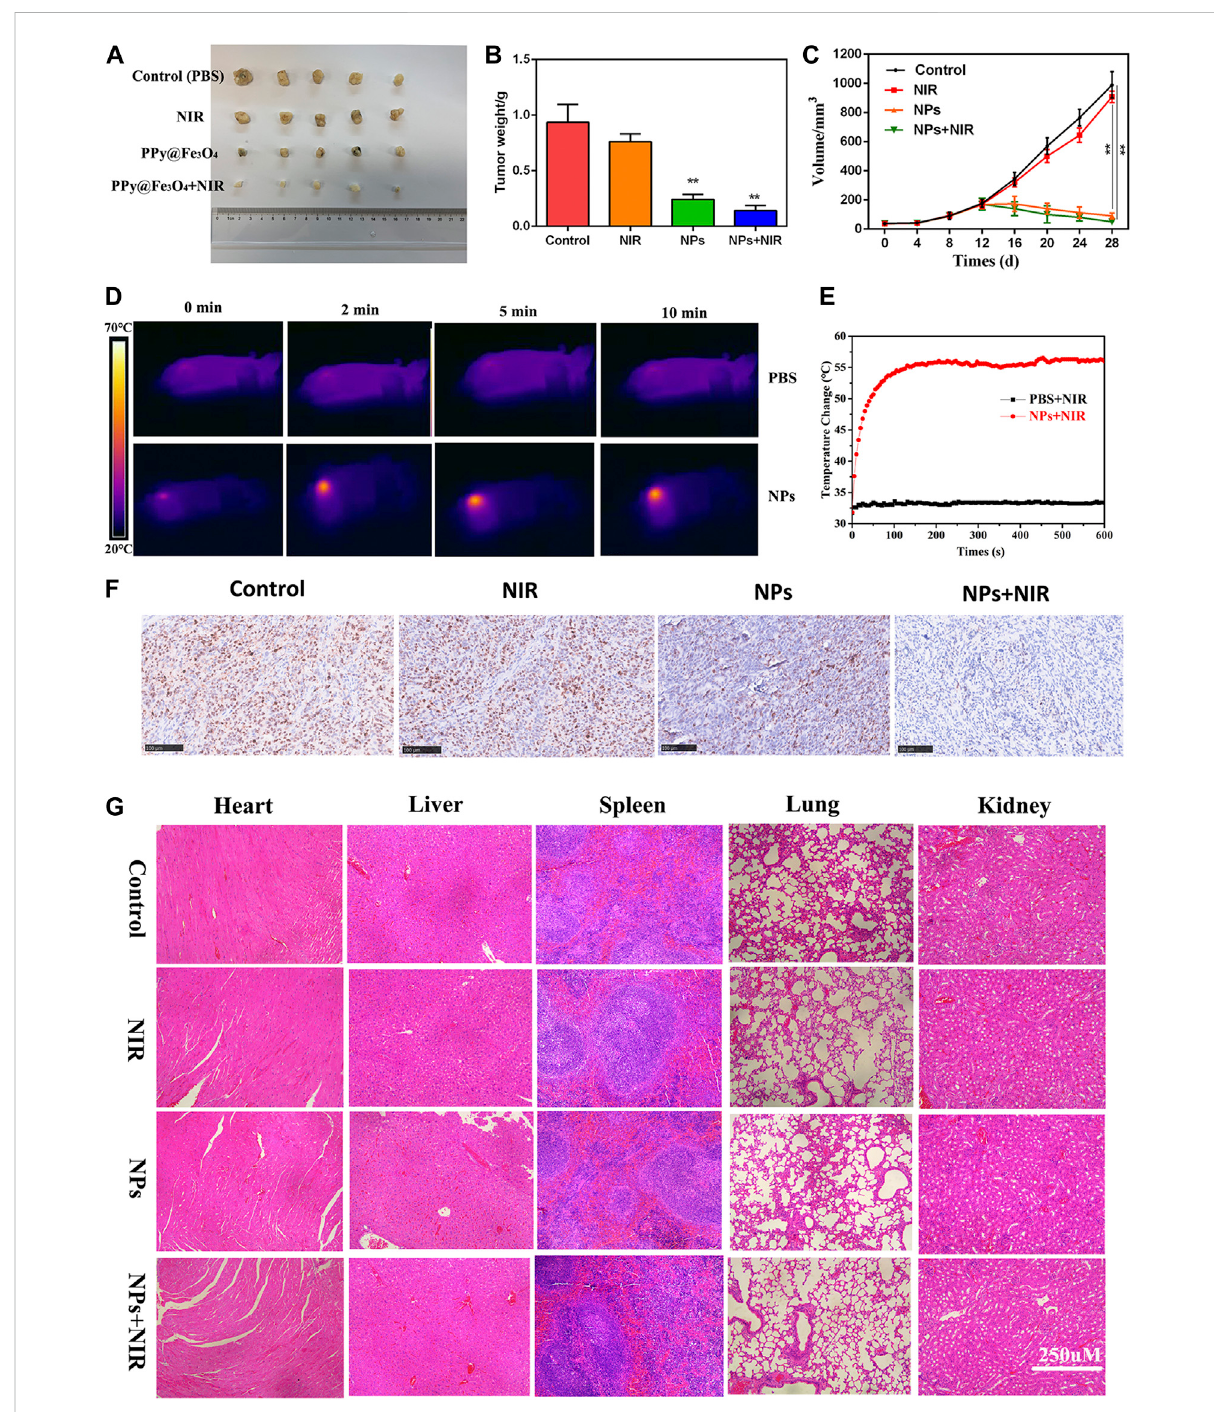
Anti-tumour activityofPPy@Fe 3 O 4 NPsinnudemousetumourcellxenografts. (A) ImagesofsubcutaneousxenografttumorsofDLD1cells. (B) The fi nal tumorweightofDLD1 cellswasshown. (C) Thetumorvolume and changeof differentgroups. (D) Thetemperaturechange and (E) infrared thermal imaging of the mice injected with PBS, NPs under laser irradiation. (F) Ki67 staining of the tumors in the control group and other treated groups. (scale bar: 100 μ m). (G) H&E staining of the main organs from the control and treatment groups. (scale bar: 250 μ m). **p <